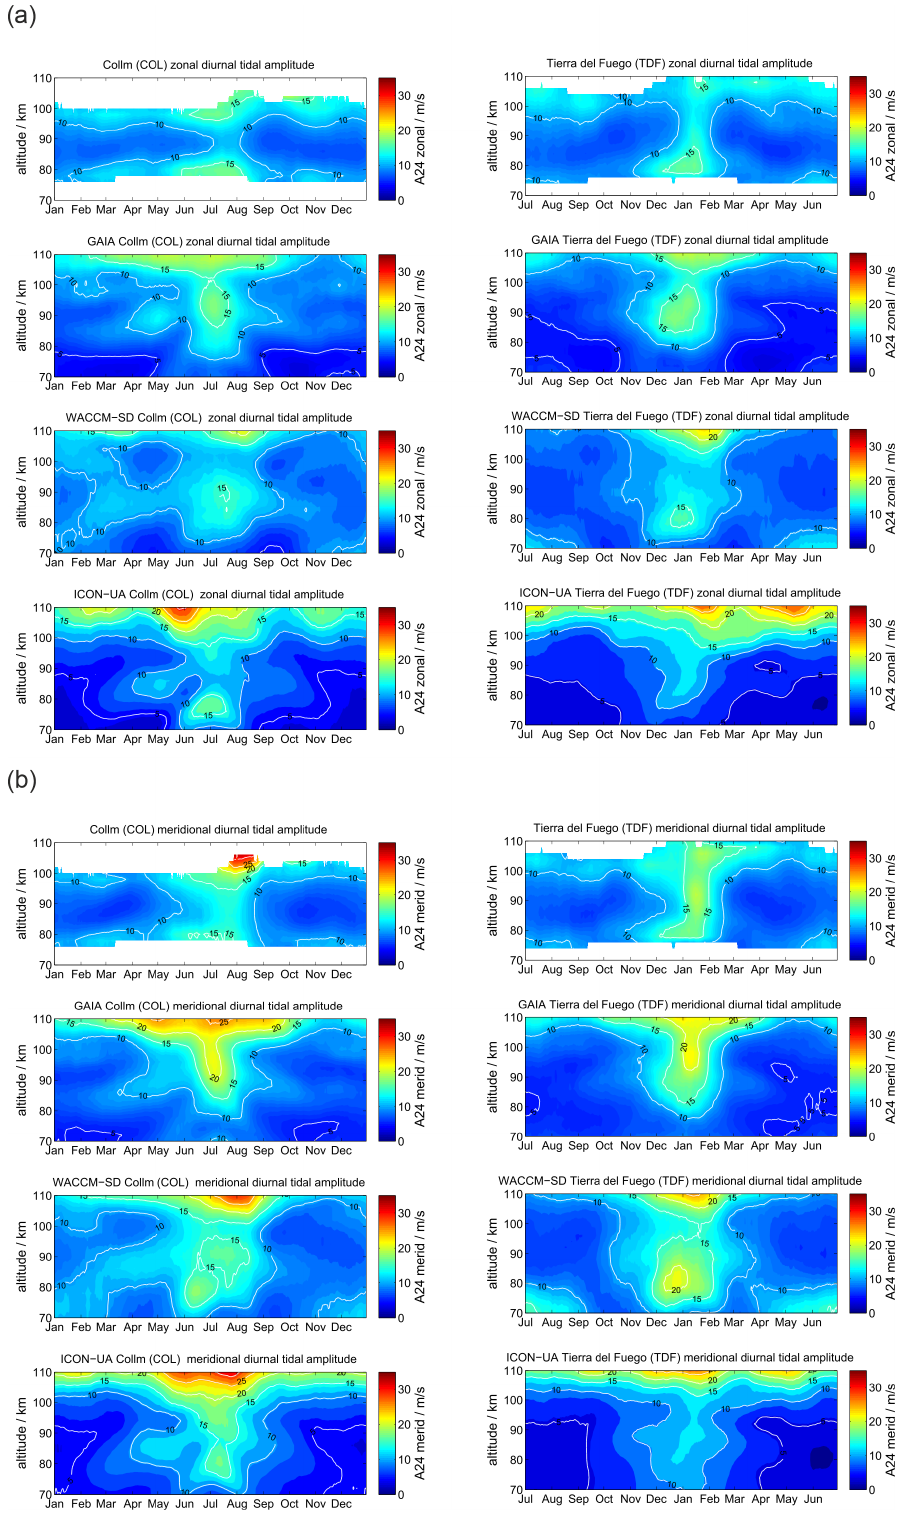
Figure 10. The same as Fig. 2, but for the diurnal tidal amplitudes above COL and TDF.